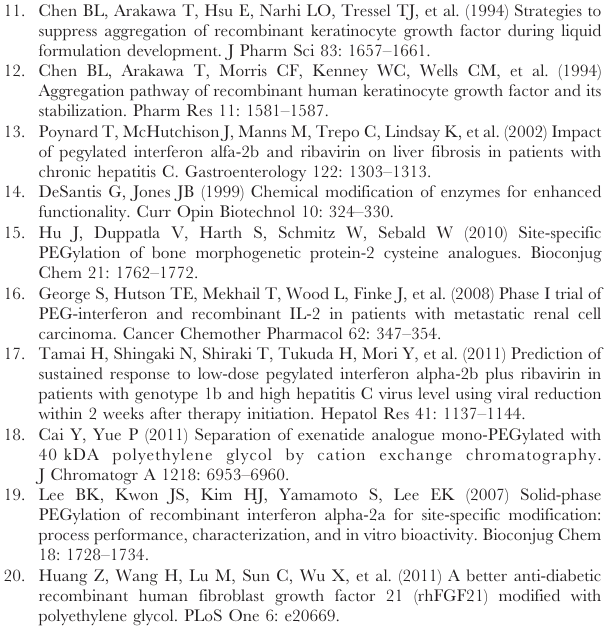
Figure S2 SDS-PAGE analysis of the solution-phase Alk- PEGylated rhKGF-1. Lane M, molecular weight standards; lane a, non-PEGylated rhKGF-1; lane b, solid-phase PEGylated product achieved at reaction time of 8 h and PEG PEG-to-protein molar ratio of 10; lane c–f, PEGylation products obtained at reaction time of 8 h and PEG-to-protein molar ratio of 5, 10, 15 and 20, respectively. Figure S3 Elution profile of the solid-phase Alk-PEGyla- tion mixture from Heparin-Sepharose